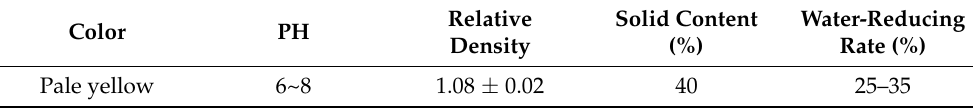
Table 4. Technical index of the water-reducing agent.